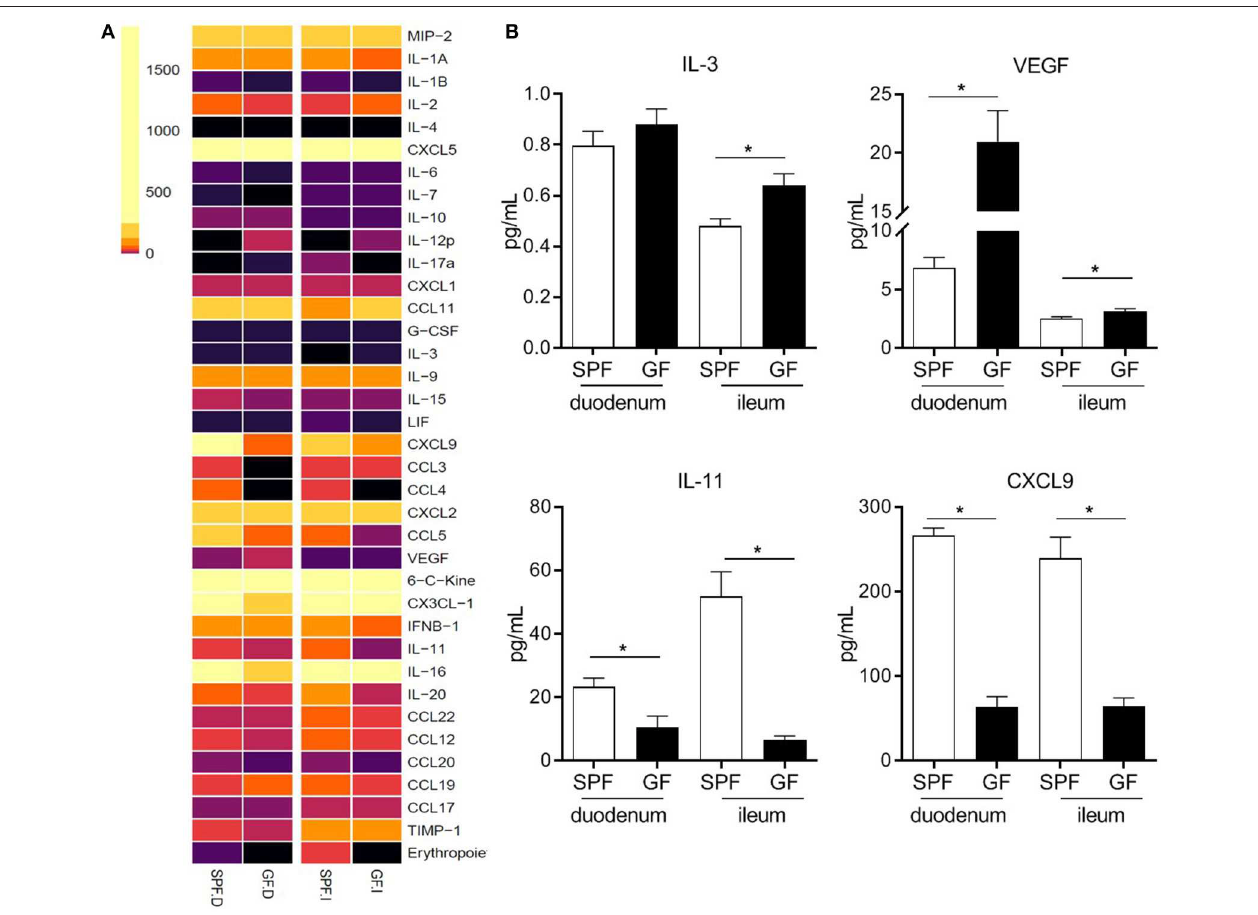
FIGURE 4 | Heatmap of chemokine and cytokine protein levels in proximal (duodenum; D) and distal (ileum; I) small intestinal homogenates from GF and SPF mice as determined by protein array (A) . Relevant proteins differentially produced both in the proximal and distal small intestine of SPF and GF mice (B) . Data from 6 mice (A,B) represented as mean ± SEM, * P <